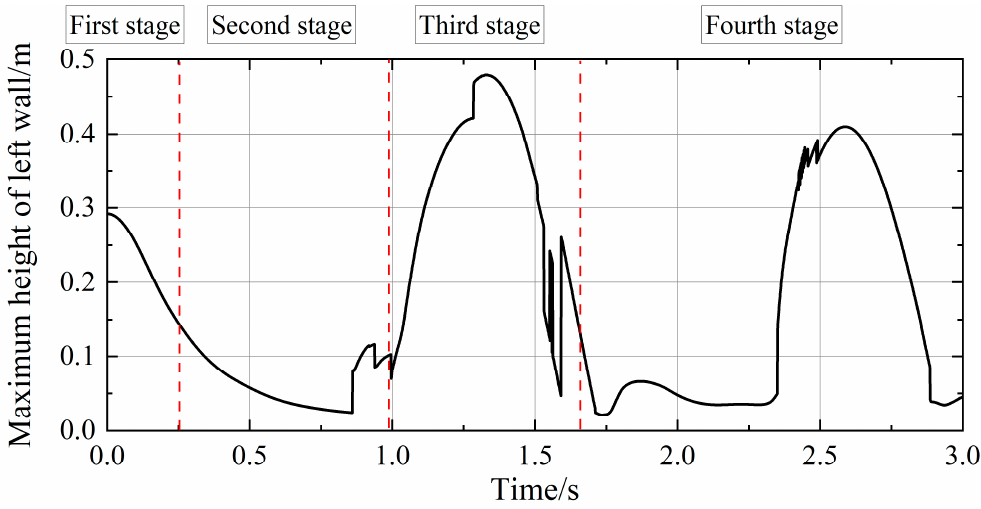
Figure 4. Changes in the height of the water column on the left wall. When t = 0.85 s, the separation beads which are formed during the water re fl ux pro- cess will cause the water column on the left side of the container to increase slightly. At